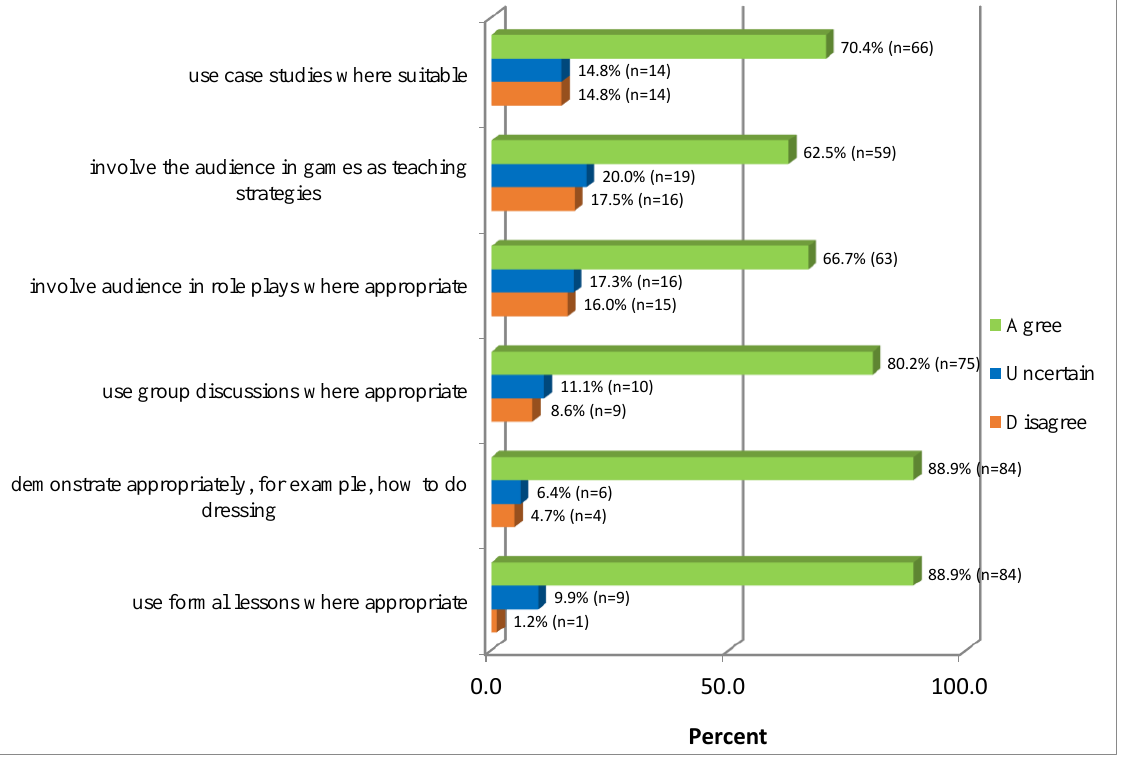
Figure 2: Ability of Novice nurses to use different teaching methods of